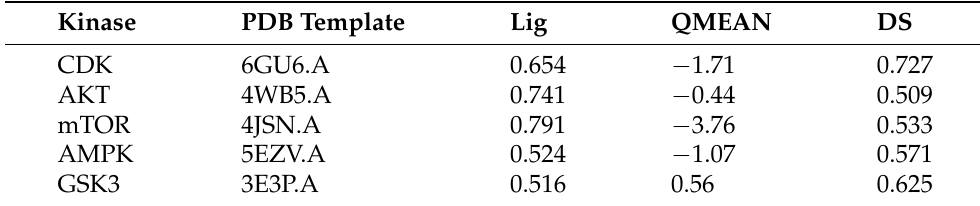
Table 2. Summary of the results from the modelling (QMEAN), ligandibility (Lig) and druggability (DS) calculations for the selected kinases of L. braziliensis